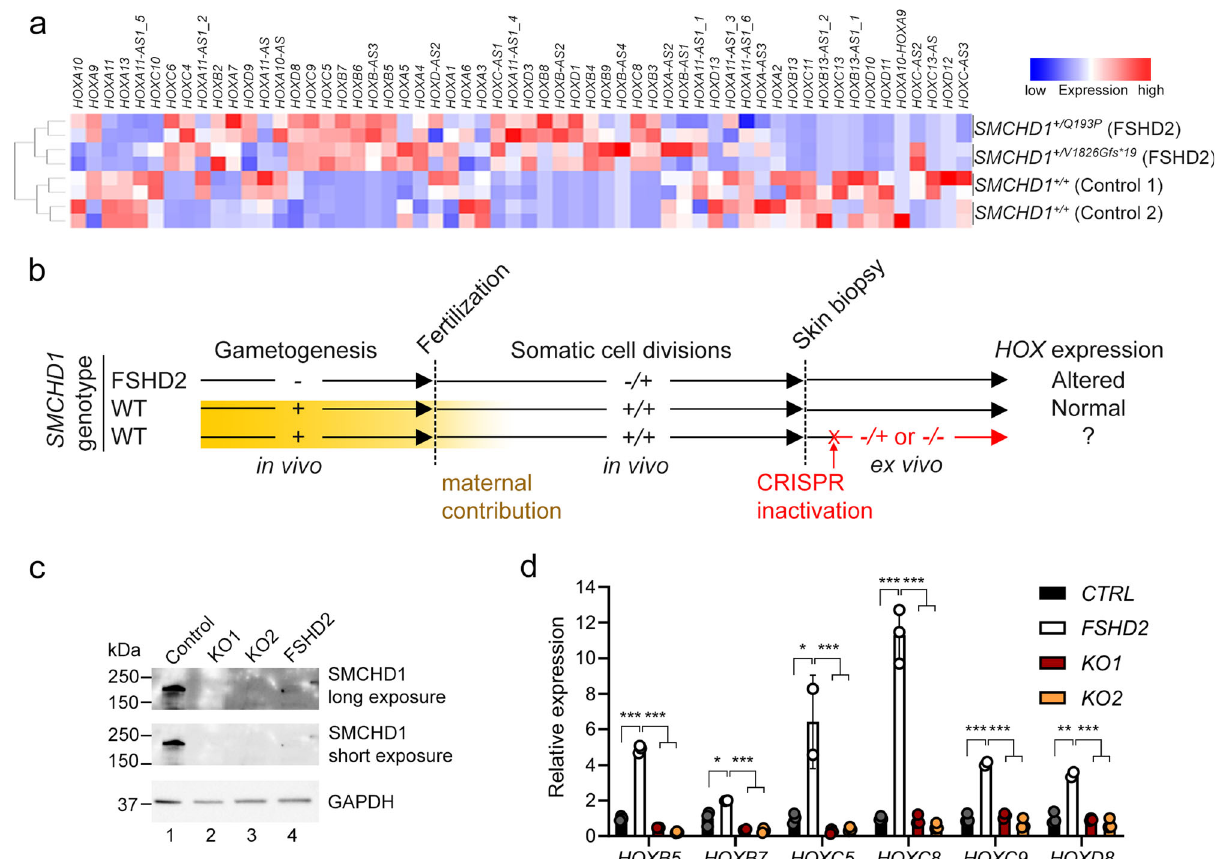
Fig. 6 Germline, but not adult, SMCHD1 de fi ciency leads to HOX dysregulation in human cutaneous fi broblasts. a RNA-seq performed on controls and FSHD2 patient fi broblasts reveal dysregulations of HOX expression when SMCHD1 was mutated in the germline. b Schematic of experimental design to determine whether HOX dysregulation is the result of germline or somatic SMCHD1 haploinsuf fi ciency. SMCHD1 was CRISPR/ Cas9-inactivated ex vivo in control fi broblasts using two distinct guide RNAs (KO1 and KO2). Yellow box represents maternal contribution of SMCHD1 which diminishes rapidly post- fertilization. c Western blot in fi broblasts cell extract show successful knockout of SMCHD1, resulting in protein-null alleles. FSHD2 cells used here are + / V1826Gfs*19 . d qPCR shows that, unlike in FSHD2 cells, somatic knockout of SMCHD1 in adult cells does not lead to the upregulation of HOX . P values were calculated by 2-tailed unpaired Student ’ s t test. * p < 0.05, ** p < 0.01, *** p < 0.001. Data are presented as mean values±